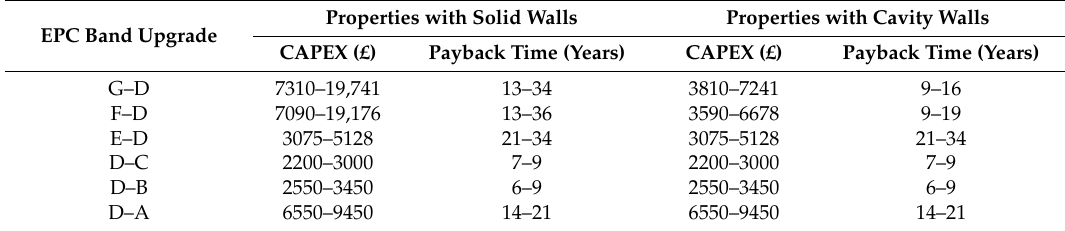
Table 6. Capital cost and payback times of EPC upgrades under the VSDLT scheme.